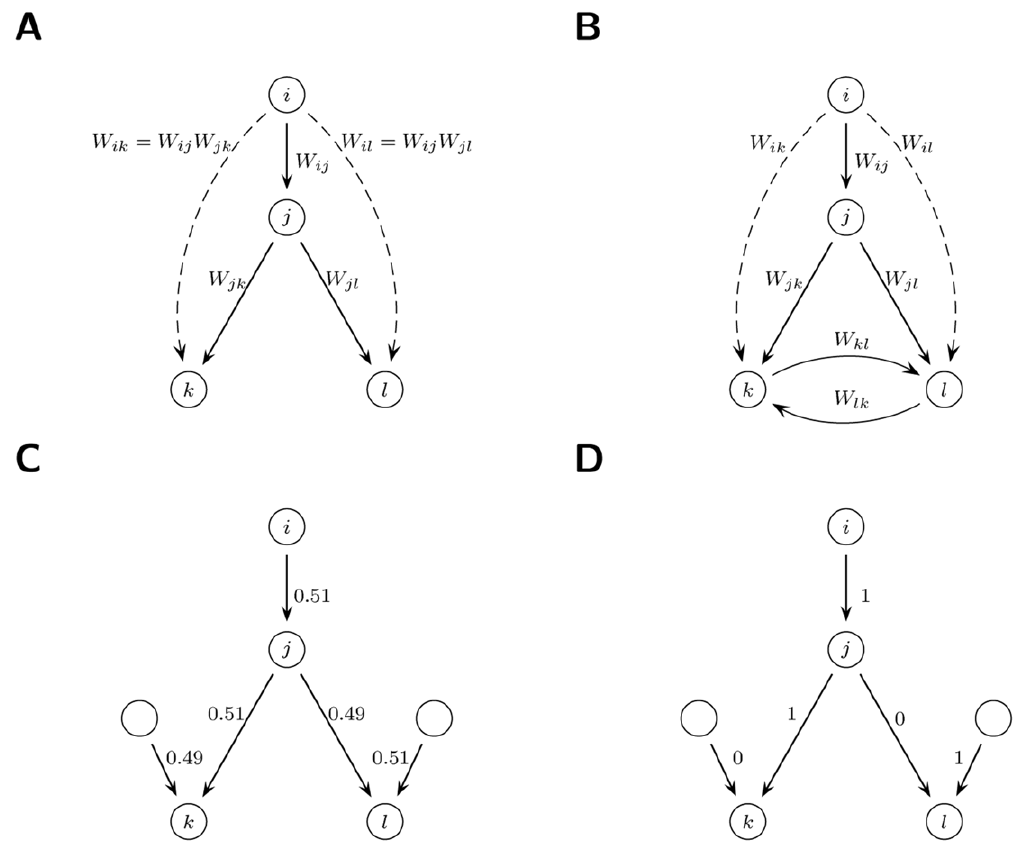
Figure 1. Ownership and Control. ( A&B ) Direct and indirect ownership. (A) Firm i has W ij percent of direct ownership in firm j . Through j , it has also an indirect ownership in k and l . (B) With cycles one has to take into account the recursive paths, see Appendix S1, Section 3.1. ( C&D ) Threshold model. (C) Percentages of ownership are indicated along the links. (D) If a shareholder has ownership exceeding a threshold (e.g. 50% ), it has full control (100%) and the others have none (0%). More conservative model of control are also considered see Appendix S1, Section